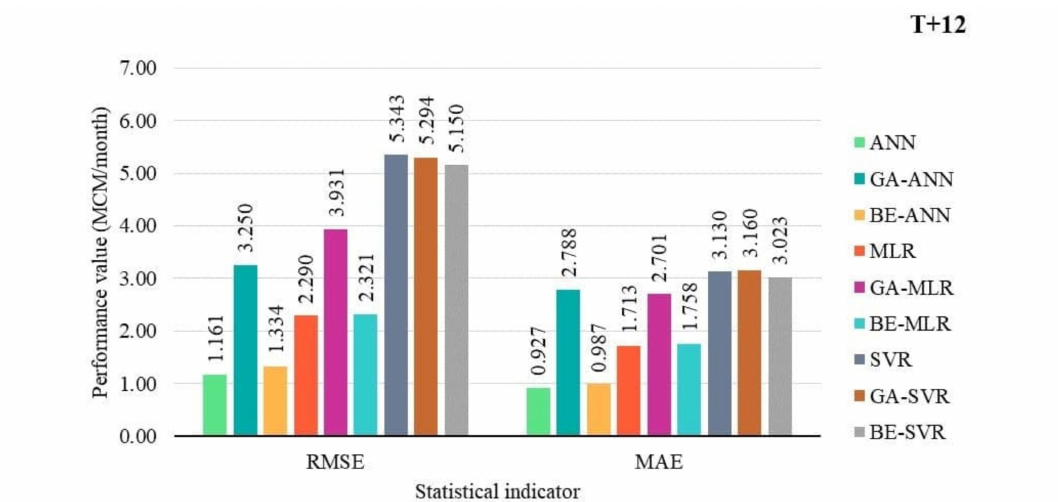
Figure 5. Comparison of nine ML models’ prediction errors (i.e., RMSE and MAE) for four lead times. At the lead time of three months (T + 3), the BE-ANN model showed high prediction accuracy, with average an OI and NSE of 0.972, an OI of 0.989, NSE of 0.955, r of 0.980, RMSE of 1.136 MCM/month, and MAE of 0.957 MCM/month. In contrast, ANN